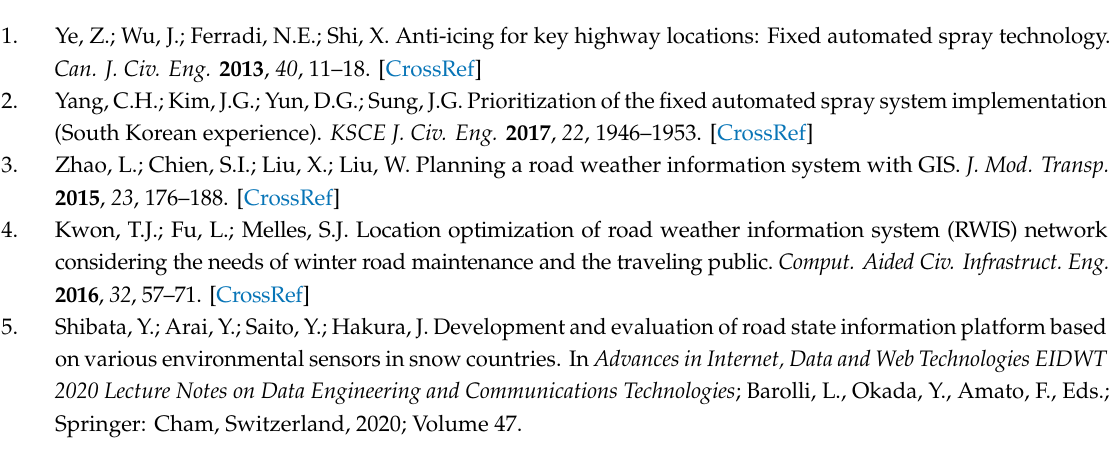
Supplementary Materials: Software source codes and resulting data corresponding to the used KNN, ANN and comparing algorithms are available online at http: // www.mdpi.com / 1424-8220 / 20 / 21 / 6395 /